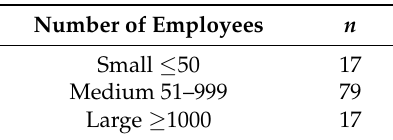
Table 3. Size of national